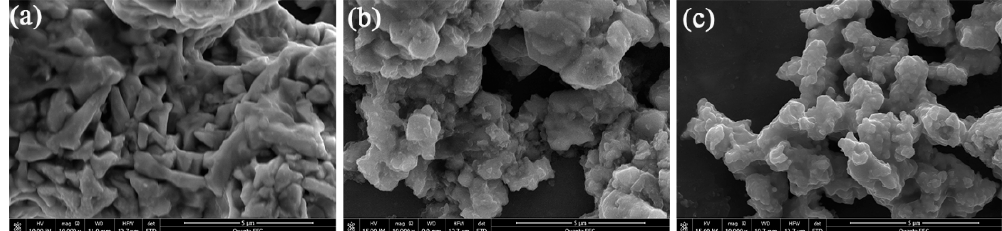
Figure 4. The SEM images of ( a ) Li 2 MoO 3 , ( b ) Li 2 Mo 0.95 Co 0.05 O 3 and ( c ) Li 2 Mo 0.90 Co 0.10 O 3 .